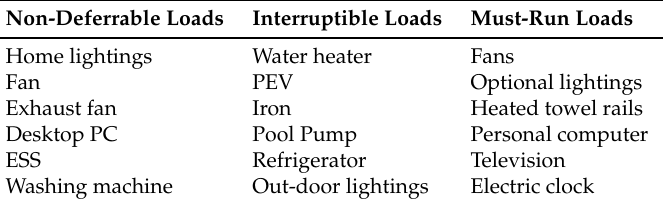
Table 3. Appliances classification.